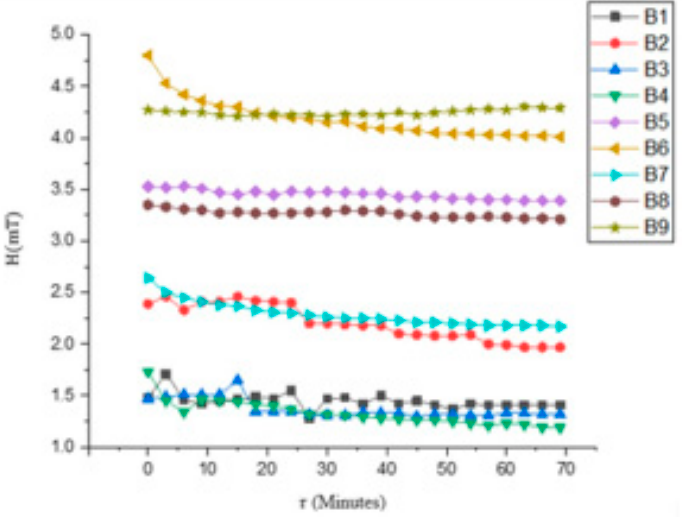
Figure 9. Characterization of the magnetic field of the solenoid with respect to time.